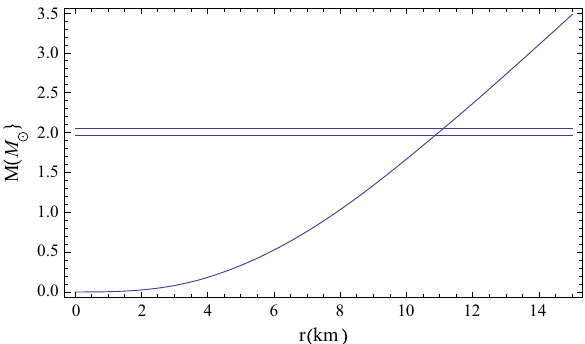
Fig. 8 VariationoftheanisotropicparameterofPSRJ0348+0432 con- sidering α = 0 . 4